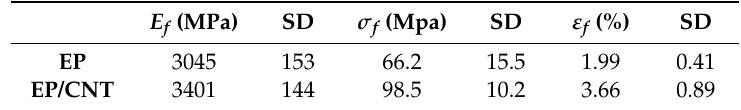
Table 2. Four-point-bending test results of neat epoxy resin and CNT/epoxy nanocomposites. The numbers represent mean values and the standard deviation (SD).